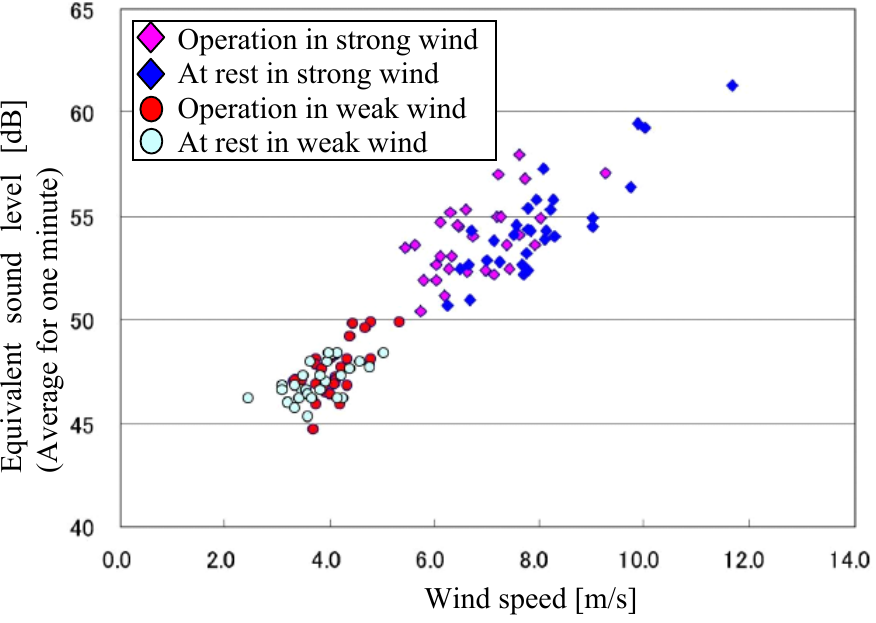
Figure 3. An example of a noise survey for a Wind-Lens turbine